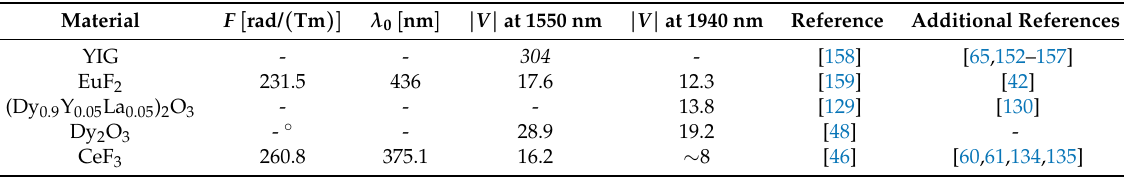
Table 3. A brief overview of magneto-active materials for the NIR-MIR FDs ( λ > 1100 nm). The Verdet constant dispersion V ( λ ) is given by the single-transition model in Equation (13) with the specified ( F , λ 0 )-parameters; the G -parameter is equal to 0 for all materials. The listed V -values are the absolute values of the Verdet constant, specified in rad/ ( Tm ) . For the YIG crystal, the saturated Verdet constant is specified in rad/m. ◦ A function different from the model in Equation (13) for the Verdet constant dispersion may be found in the listed